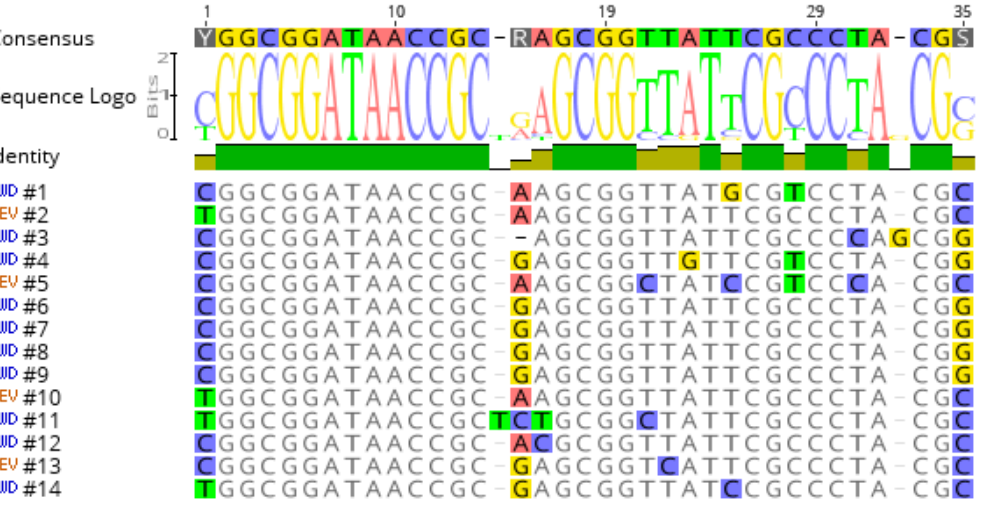
Figure 4. Definition of a highly conserved consensus. The conserved sequences adjacent to each of the fourteen hotspots are shown with the 35 bp consensus sequence on top.